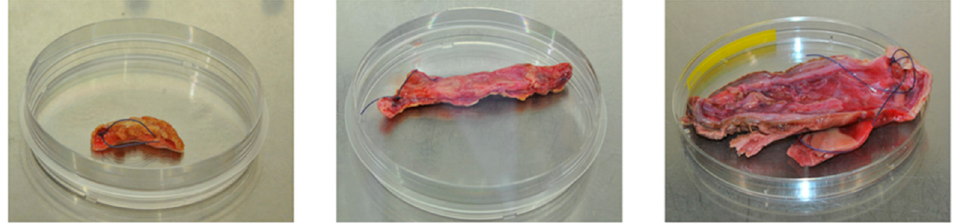
Figure 2. Abdominal aortic aneurysm samples obtained from patients after surgical treatment. Proximal part of the aneurysm is marked with stitches.